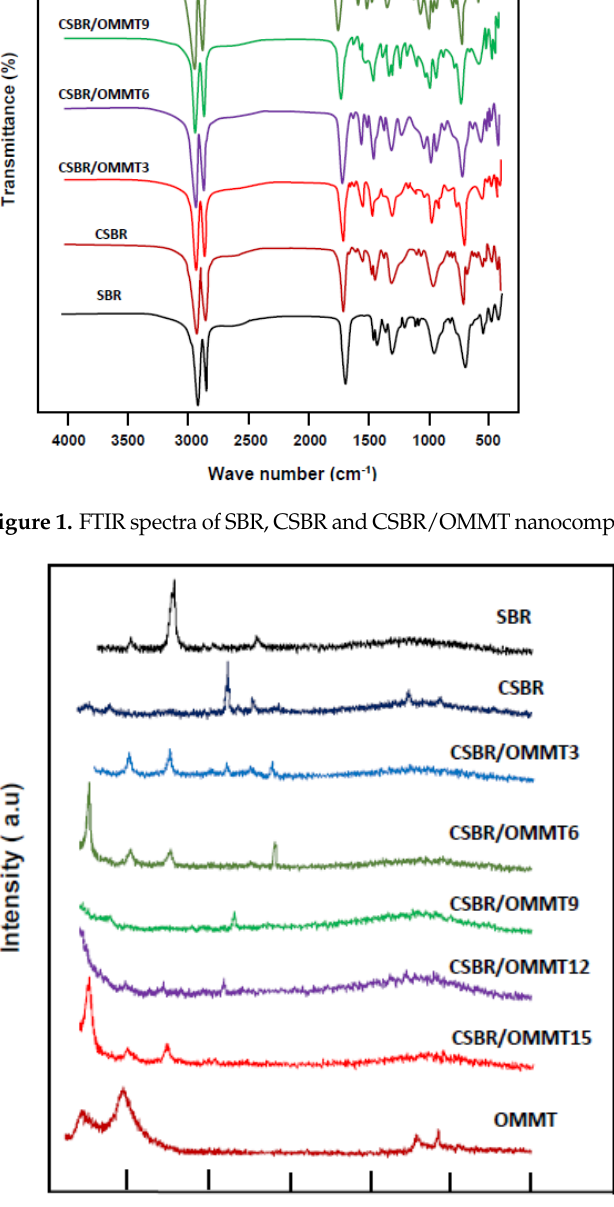
Figure 2. XRD spectra of OMMT, SBR, CSBR, and CSBR/OMMT nanocomposites with different OMMT contents.